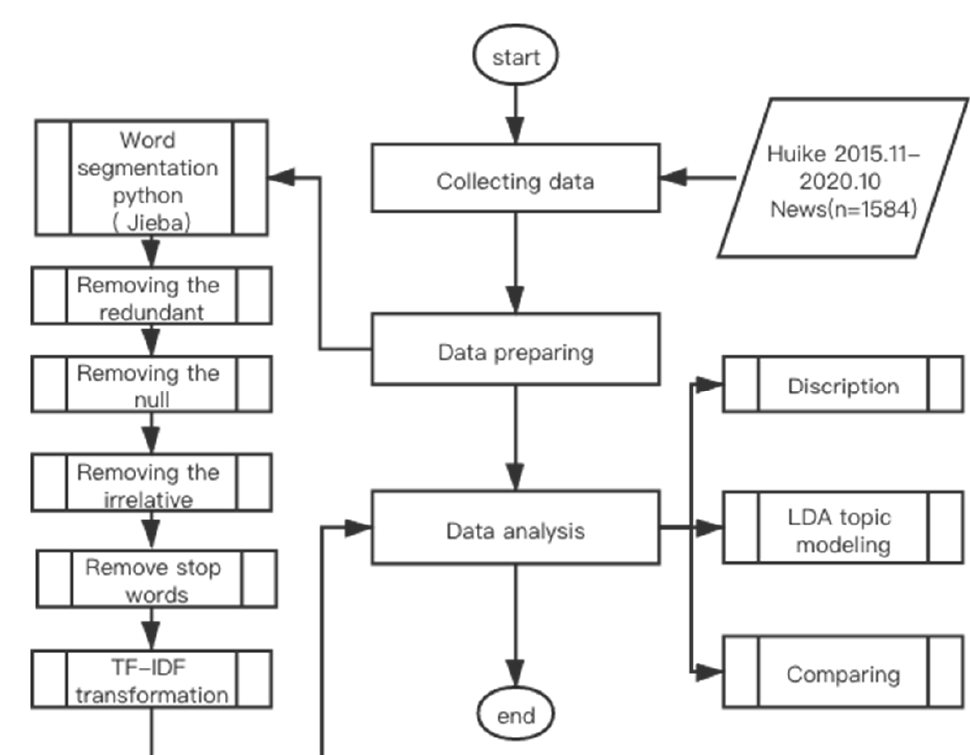
Figure 2. Data processing chart.